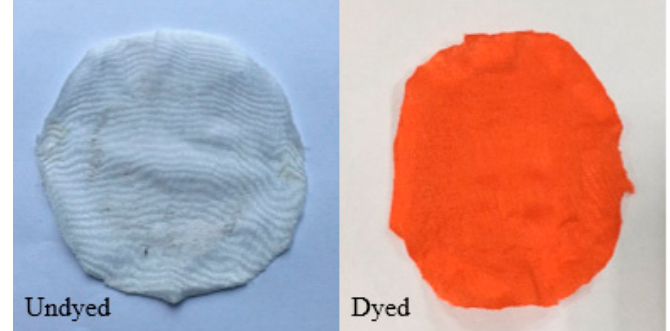
Figure 9. Anti-pilling properties of undyed and dyed warp-knitted fabrics.